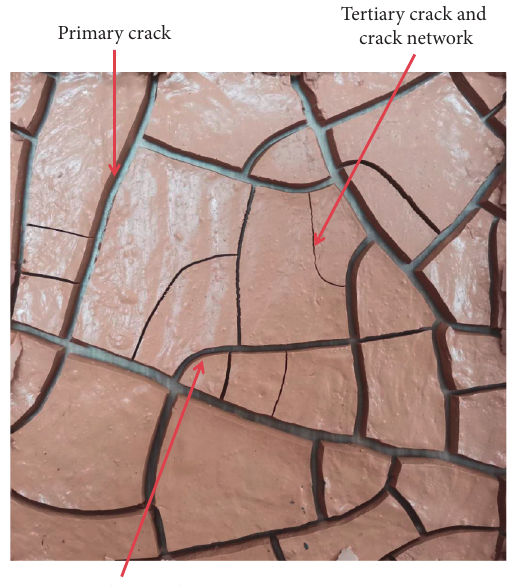
Figure 4: Tertiary crack development of sample.